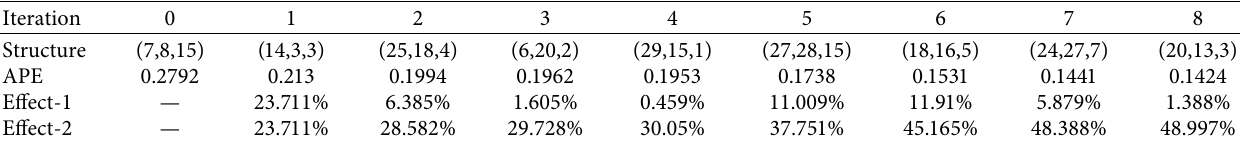
Table 2: AC iteration results on RMSA.